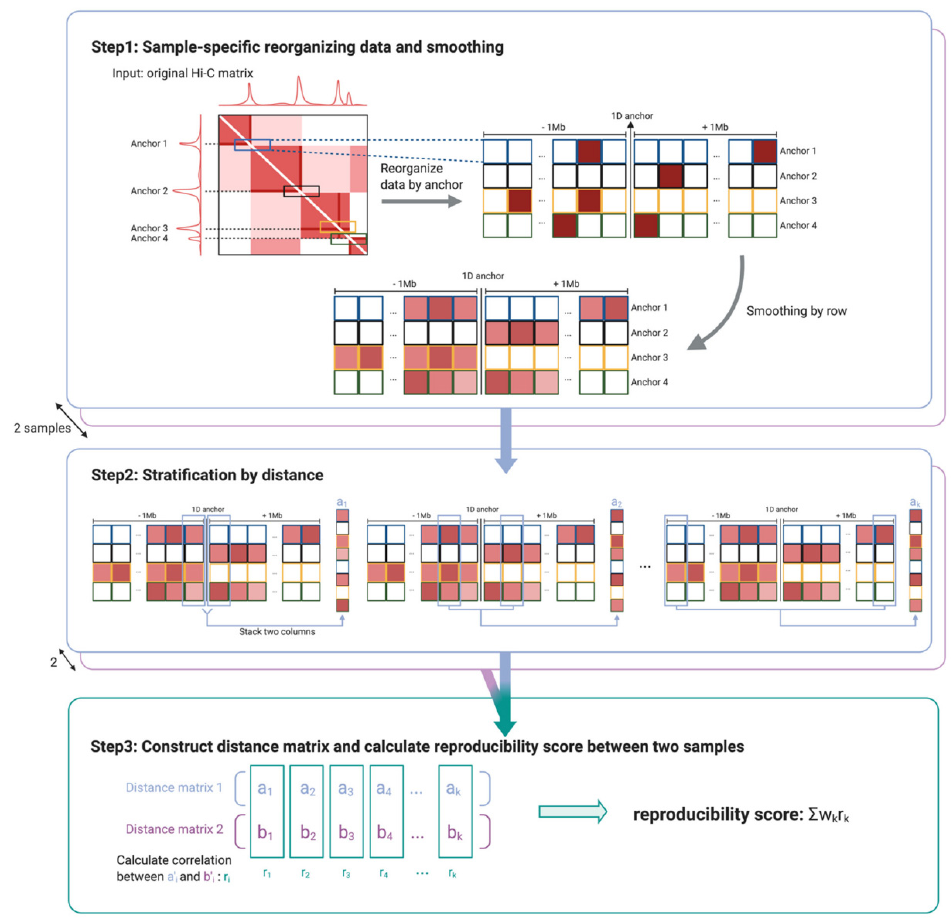
Figure 1. Cartoon illustration of HPRep. Step 1 involves first identifying anchors (i.e., 1D ChIP peak sites) and then extracting all interactions between these anchors and bins within a specified genomic distance from the anchors. This is followed by a one-dimensional smoothing procedure. Stratification by 1D genomic distance is performed in step 2 so that the elements of vector a k represent interactions that are equidistant from their respective anchors, k bins apart. In the final step, the Pearson correlation coefficients are calculated between vectors from two samples both of stratum k , repeated over all k , and these Pearson correlation coefficients were combined in a weighted average to yield the final reproducibility